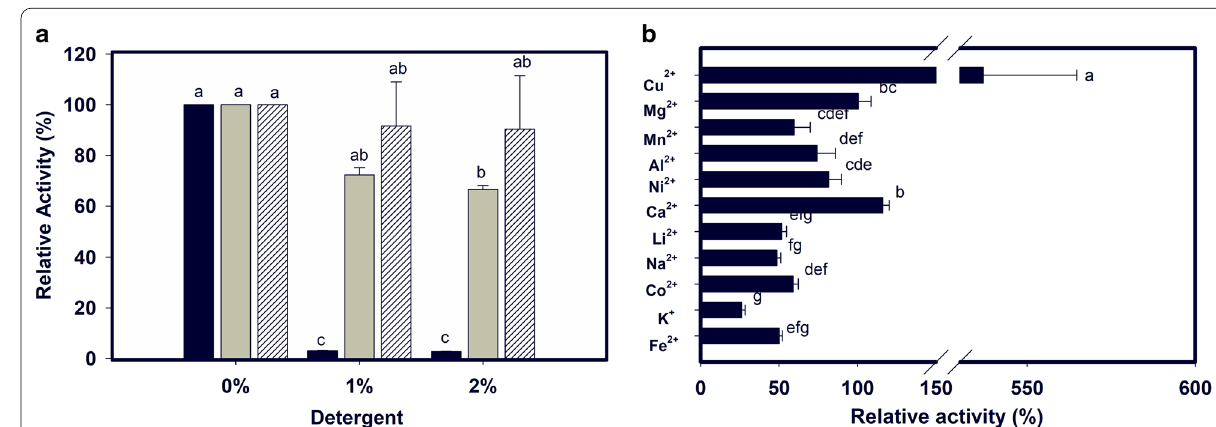
Fig. 5 Influence of detergents and ions on laccase enzymatic activity. a Reactions were performed using SDS (black bars), Triton x‑100 (gray bars) and Tween 80 (striped bars) detergents at concentrations of 0%, 1%, and 2%. b Reaction control was performed without the presence of additives (ions) and was used as the basis for the calculation of the other percentages. The tests were performed with 3 replicates. The values followed by the same letter do not differ statistically, according to the ANOVA and Tukey test, with a 5%